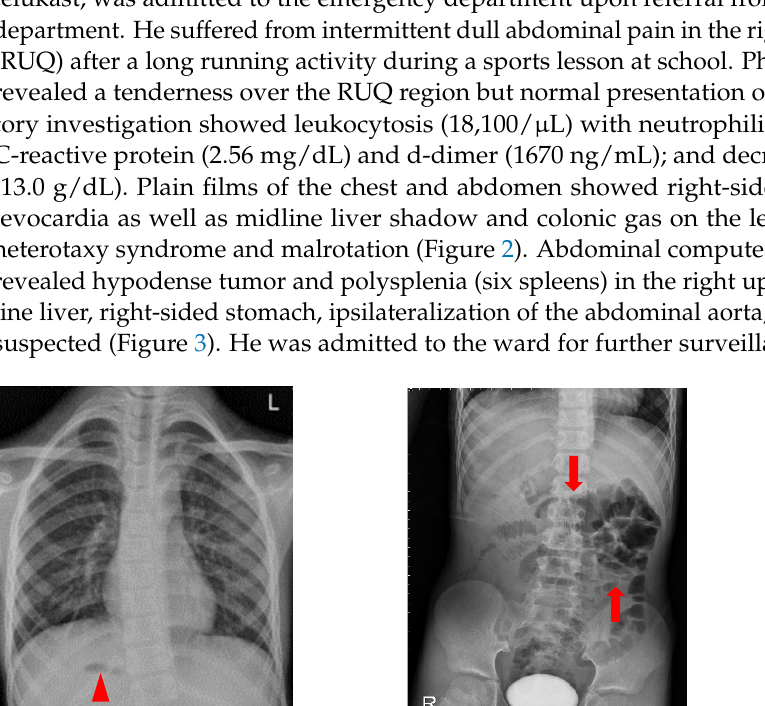
( b ) Figure 3. CT of the abdomen showing that the liver is full in the midline of the abdomen: ( a ) the hypodense tumor is located in the right abdomen <star>, and the superior mesentery vein <arrow head> lies to the left of the superior mesentery artery; ( b ) seven arrowhead spleens <arrows> are suspected beside the tumor (all spleens cannot be shown in two pictures). See the complete series of CT in Supplementary Materials Figure S1: CT of abdomen. During hospitalization, no elevated levels of tumor makers, such as alpha feto-pro- tein (<0.5 ng/mL) and carcinoembryonic antigen (0.3 ng/mL), were observed. A whole- body positron emission tomography (PET) scan revealed tumor or inflammation in the right upper abdomen (Figure 4). A clinical diagnosis of a right upper abdominal tumor was made. Surgical intervention was agreed upon after discussion with the patient’s fam- ily. Preoperative cardiac sonography showed an interruption of IVC with a continuation of the azygos vein, ipsilateralization of the abdominal aorta and IVC, and juxtaposition of the atrial appendage. Furthermore, normal intra-cardiac structures and cardiac function with functioning left ventricular ejection fraction (68%) were observed. Laparoscopic tumor excision (Figure 5) was performed. He was discharged 4 days after the operation, and his condition was cured without any complications. The patho- logical report showed splenic tissue with hemorrhagic infarction.